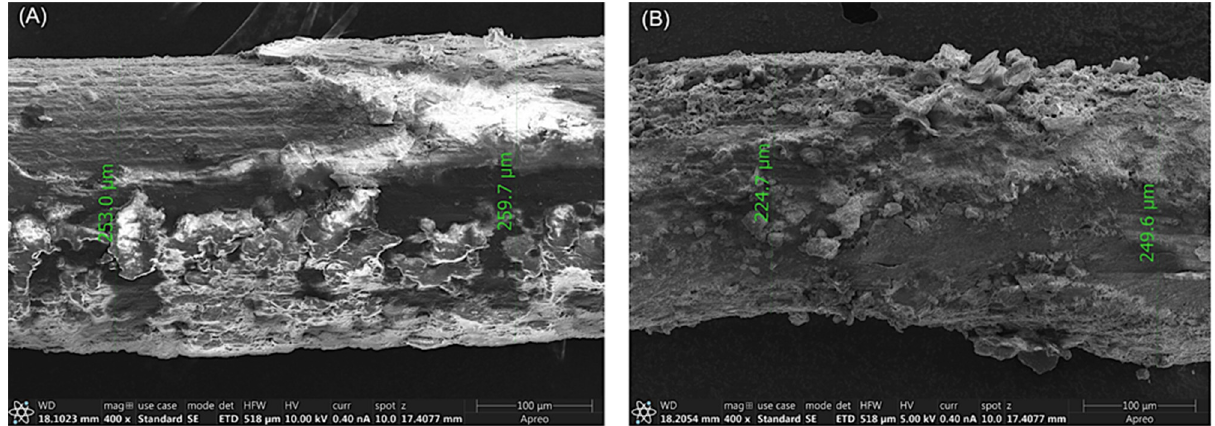
Figure 6. SEM imaging for the iron wire upon heat treatment at 450 °C: ( A ) for 4 h after the first week, and ( B ) for 3 h after the second week. and ( B ) for 3 h after the second